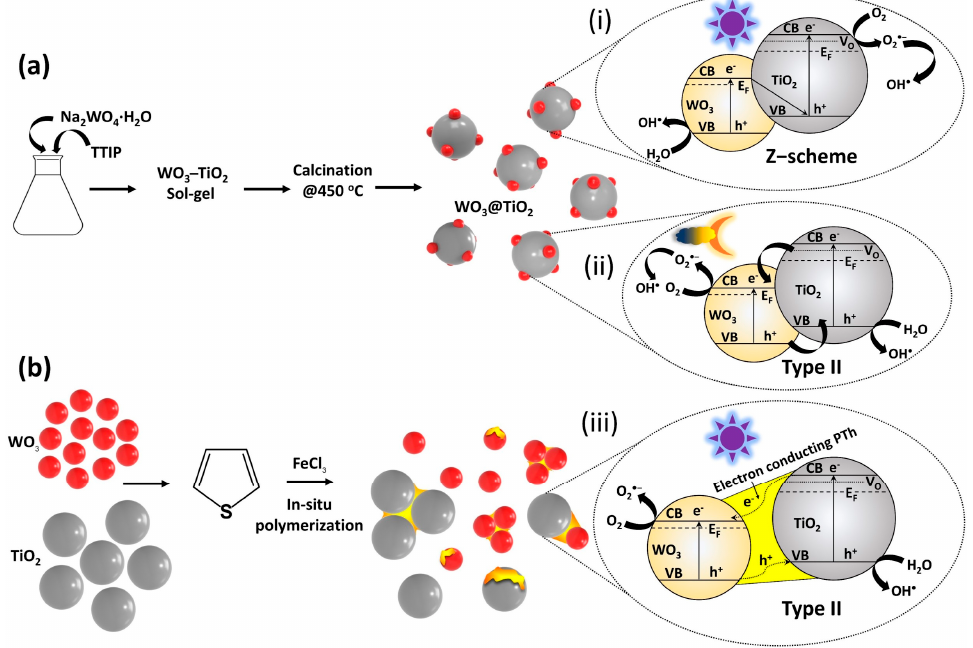
Figure 7. A schematic drawing illustrating the preparation, structures and charge transport mechsnisms of: ( a ) the composite metal oxides (WO 3 @TiO 2 ) particles during the daytime (i) and during the night time (ii); ( b ) the mixed metal oxides (TiO 2 /PTh/WO 3 particles (iii).